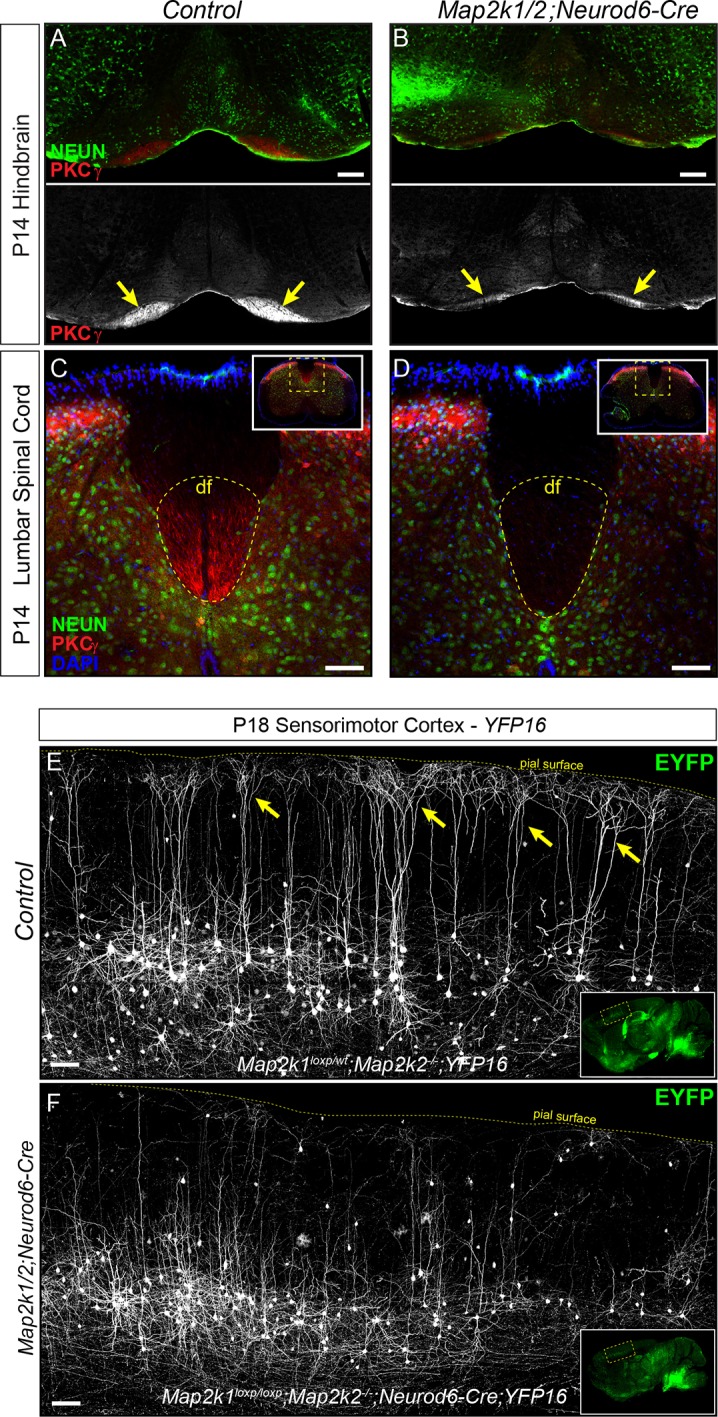
Corticospinal tract defects in Map2k1/2;Neurod6-Cre mice.(A–D) To further evaluate the loss of layer 5 projection neurons, we examined the expression of a well-established corticospinal tract marker, PKCγ. Compared to control hindbrains (A) and spinal cords (C), a profound decrease in corticospinal tract labeling was observed in the Map2k1/2;Neurod6-Cre hindbrain (B-yellow arrows, scale bar=200 µm) and spinal cord (D), consistent with the reduced number of CTIP2+ layer 5 neurons (df=dorsal funiculus, n=3, scale bar=50 µm). (E–F) The Thy1-YFP reporter line, YFP16, labels a small fraction of layer 5 neurons in sensorimotor cortex. Many layer 5 neurons labeled in this line have large complex apical dendritic arbors (yellow arrows) that are consistent with the known morphology of subcerebral projection neurons, including corticospinal neurons. EYFP expressing neurons heavily branch in layer 1 as shown in representative confocal images of sagittal sections from P18 control mice (E, yellow arrows). In Map2k1/2;Neurod6-Cre cortices, we noted a significant reduction in the number of EYFP labeled neurons in layer 5 with complex apical dendritic arbors (F) (n=3, scale bar=100 µm).DOI:
http://dx.doi.org/10.7554/eLife.11123.00510.7554/eLife.11123.006Figure 2—source data 1.Reduced expression of layer 5 neuron markers following loss of Map2k1/2.(A) Gene expression profiling of RNA extracts from the cortex of control and Map2k1/2;Neurod6-Cre mice collected at P9 (n=2) and P14 (n=3) revealed significantly diminished expression (fold change>1.5 and p<0.05) of many genes that are known to be expressed in layer 5 neurons (red filled boxes).